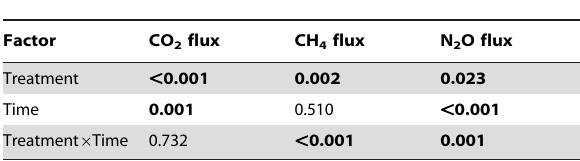
Table 2. Results of two-way analysis of variance (repeated ANOVA) showing the p values for GHG emissions responding to P application and sampling time (July; August) for paddy field soil.